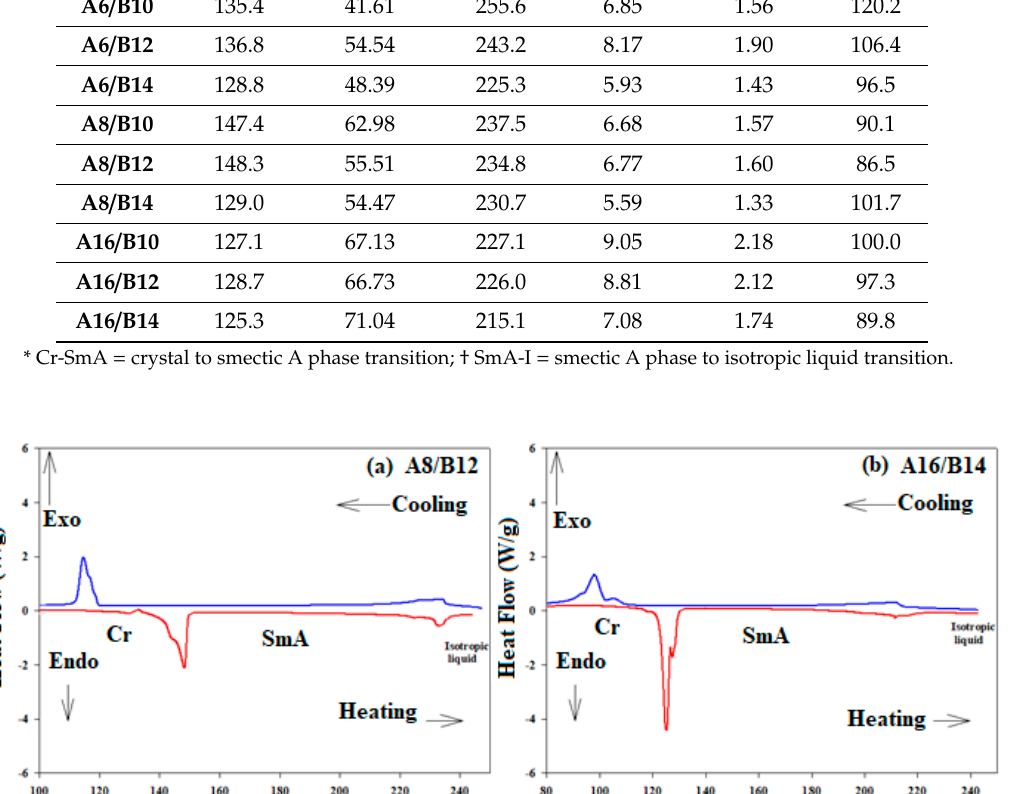
Table 1. Phase transitions: temperatures (T, ◦ C), enthalpy ( ∆ H, kJ / mol), normalized entropy ( ∆ S / R) and mesomorphic range ( ∆ T) for the SMHBCs An / Bm .